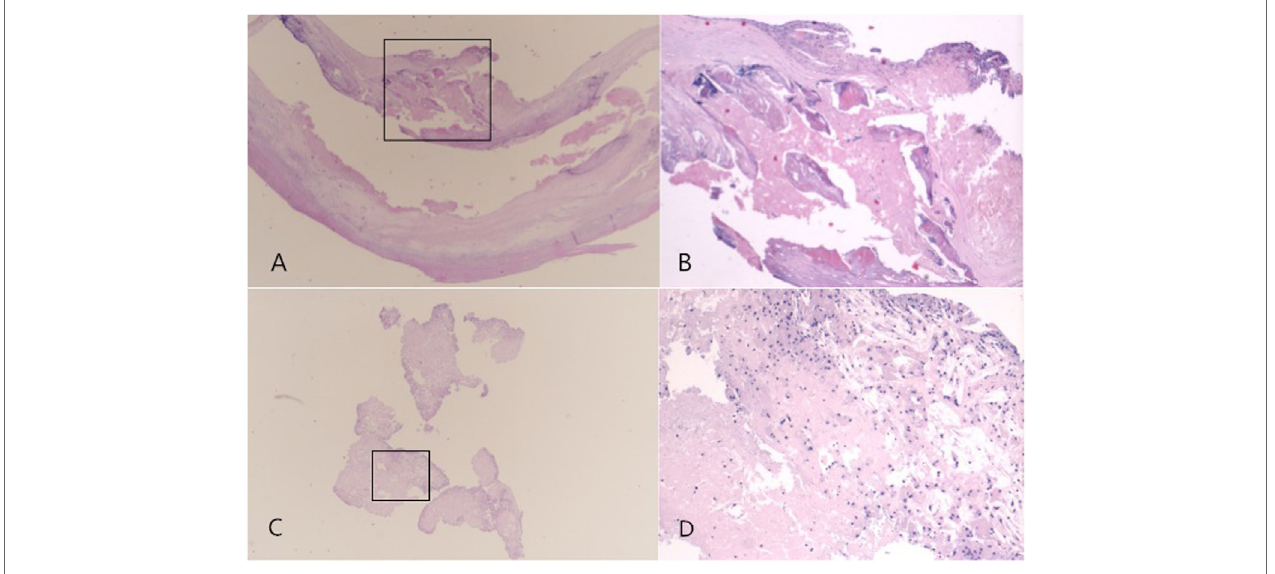
FIGURe 2 | Pathological examination: the fibrous cap in the base of floating plaque was incomplete, in which lipid necrosis and calcification can be found, and tissue cells which ingested the lipids were protrudes from the fibrous cap [HE staining; original magnification 2 × for (a) , and 4 × for (B) ]. The floating plaque was consisted of tissue cells ingesting the lipids and cholesterol clefts, there was lipid necrosis inside it [HE staining; original magnification 2 × for (C) , and 10 × for (D)